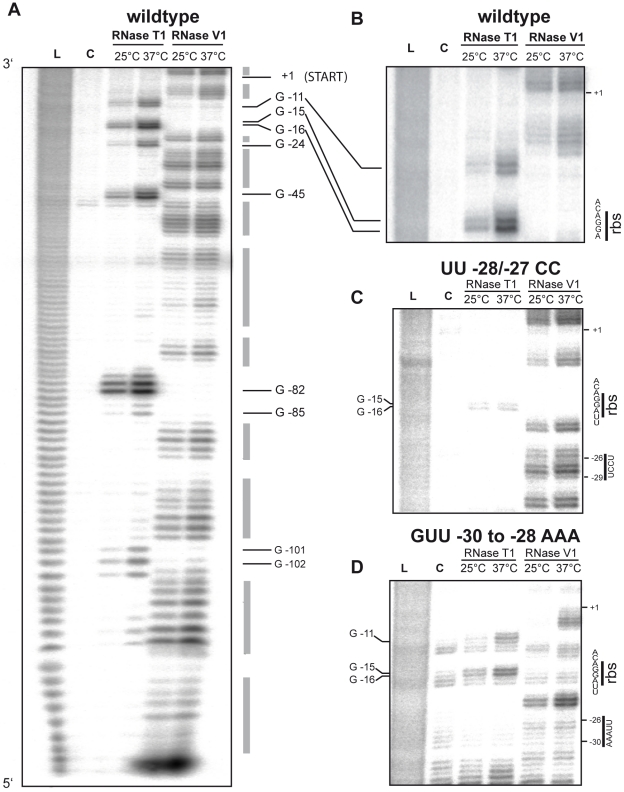
Enzymatic probing of the yscW-lcrF intergenic region variants.(A) Enzymatic hydrolysis of the yscW-lcrF wildtype sequence with endonucleases T1 (0.001 U/µl) and V (0.0002 U/µl) performed on the 5′-end labelled intergenic region between the yscW and lcrF gene on the pYV at 25°C and 37°C. The G nucleotides in single stranded regions are indicated. (B) Magnification of the enzymatic probing pattern of the fourU/Shine-Dalgarno region. (C) Enzymatic probing of the yscW-lcrF of the repressed UU-28/-27CC variant, and (D) enzymatic probing of the yscW-lcrF of the derepressed GUU-30/-28AAA variant. The RNA fragments were separated on 8% polyacrylamide gels. Lane L: alkaline ladder; lane C: controls without RNase. The Shine-Dalgarno sequence and the nucleotide exchanges are indicated.